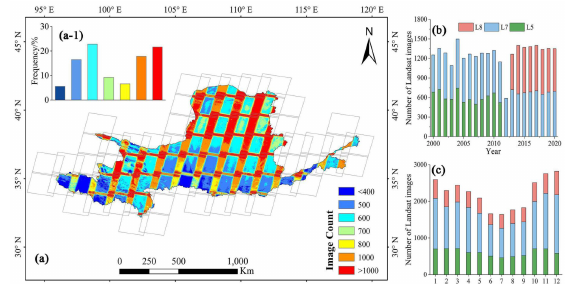
Figure 2. Spatial distribution of the number of good-quality observations within individual pixels of Landsat 5/7/8 images from 2000 to 2020 and Landsat WRS-2 path/rows (gray boxes) in the study area (a). Annual (b) and monthly (c) distribution of the number of good-quality observations of Landsat 5/7/8 images from 2000 to